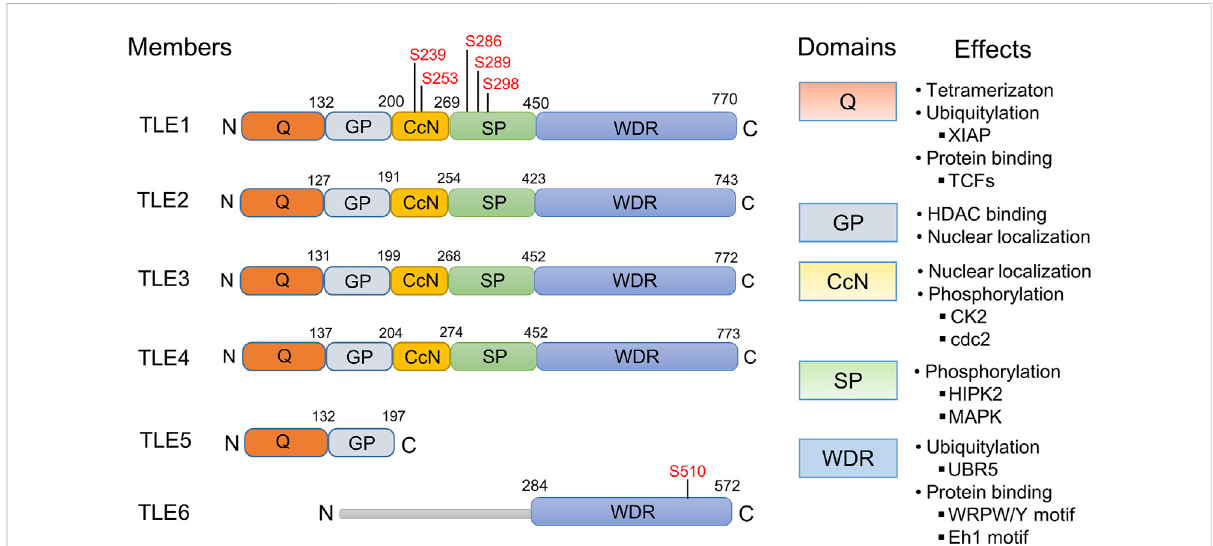
FIGURE 1 Proteinstructures,domains,andfunctionsofhumanTLEfamilymembers.ThestructureofhumanTLEfamilymembersTLE1-6isdisplayed.The phosphorylation sites in the Gly-Pro-enriched (GP) and CcN domains are labeled. Domain-speci fi c effects, not necessarily determined from studies of human TLE molecules, are presented. Protein ‒ protein binding between TLEs and TCF/LEF1 family proteins (TCFs) is mediated by the TLE Q domain (Levanonetal.,1998;Chodaparambiletal.,2014;Flacketal.,2017),whileproteinscontainingtheWRPW/Ymotif (Jenningsetal.,2006; Mahadeveraju et al., 2020) and Eh1 motif (Milili et al., 2002; Goldstein et al., 2005) bind to the TLE WDR domain. The WDR domain of TLEs interacts with the E3 ubiquitin ligase UBR5 (Flack et al., 2017), and the stability of TLEs is regulated by UBR5-mediated ubiquitination and subsequent